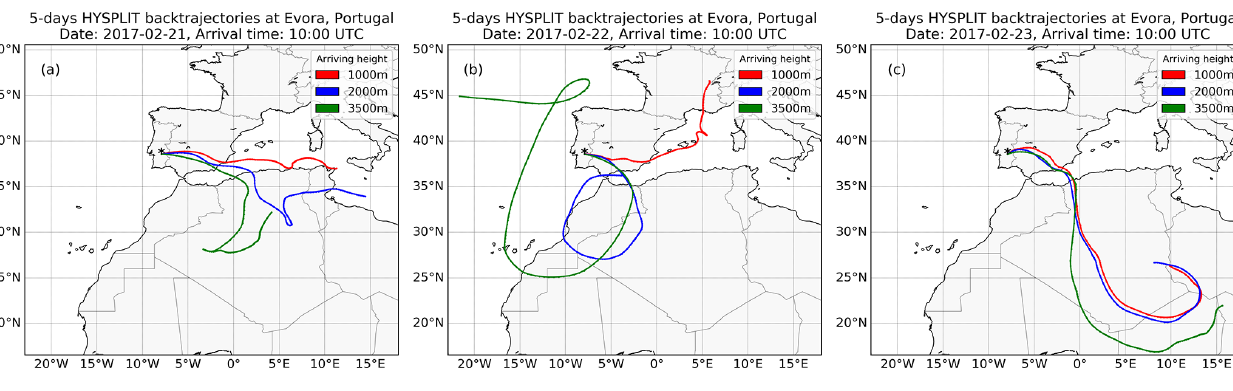
Figure 11. The 5d NOAA HYSPLIT backward trajectories ending at the position of Évora at 10:00UTC (38.56 ◦ N, − 7.91 ◦ E) for 21 (a) , 22 (b) and 23 February (c) nicely show the evolution of this particular dust